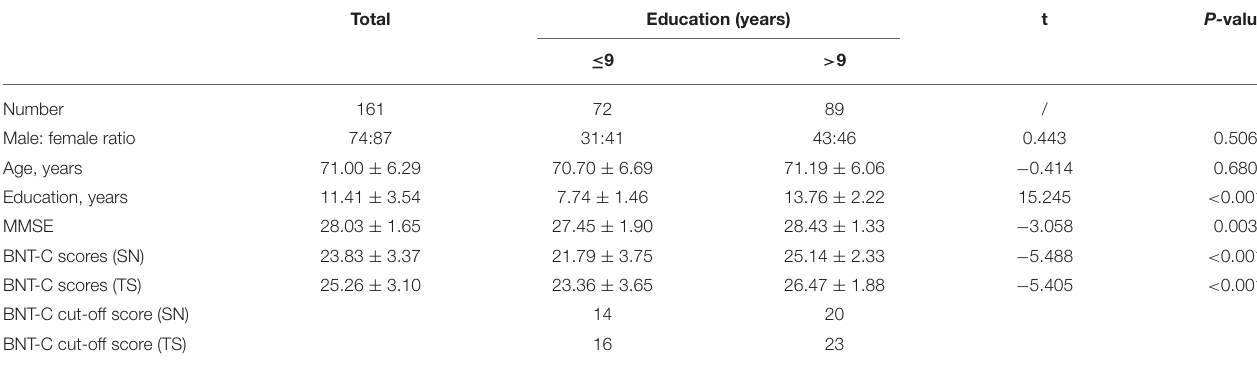
TABLE 1 | Demographic and neuropsychological data.